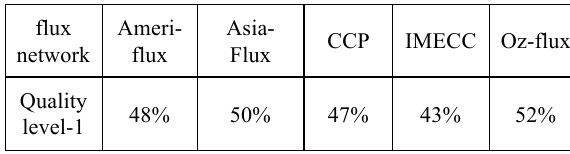
Table 3. The percentage of quality-level-1 reference data to all points for each flux network.